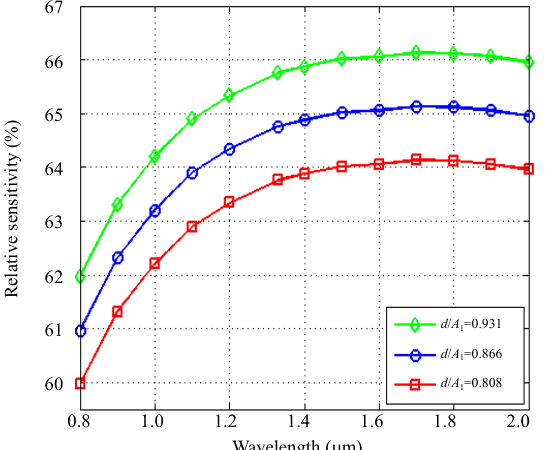
Fig. 7 Comparison of relative sensitivity with cladding air filling ratio ( d / Ʌ 1 ) variations for n =1.354.